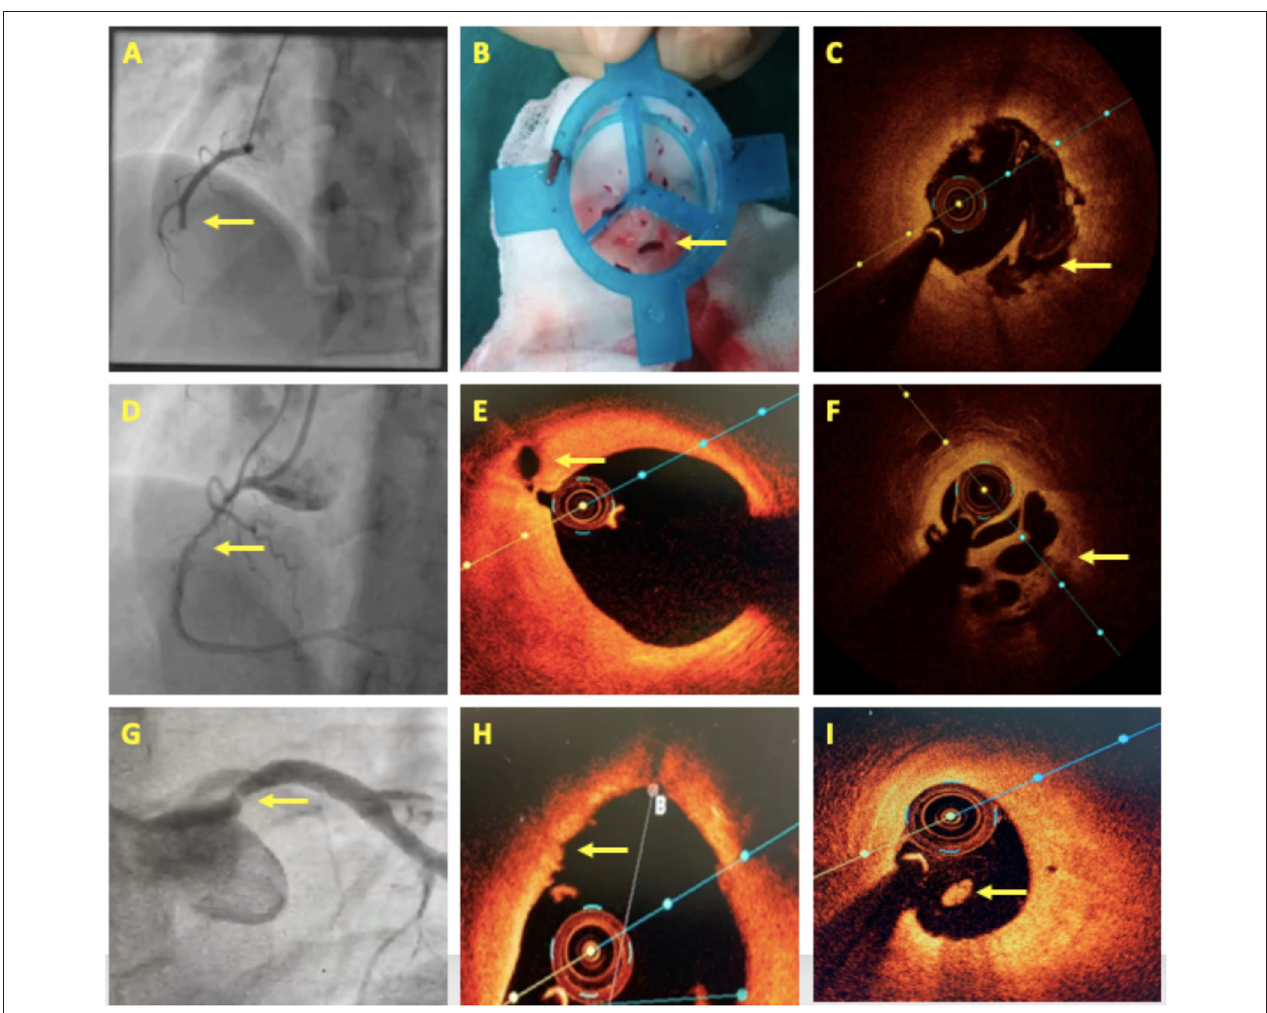
FIGURE 4 | OCT in acute coronary syndrome. (A–C) A case of acute inferior wall STEMI with mid dominant right coronary artery (RCA) thrombotic occlusion. Thrombus aspiration followed by OCT revealed plaque rupture. (D–F) A 4-day old case of inferior wall STEMI showing Mid-RCA haziness. OCT revealed proximal RCA plaque rupture and mid-RCA recanalized thrombus in a Swiss-cheese pattern. (G–I) A case of NSTEMI having a separate origin of LAD and LCx with a significant stenosis in the proximal LAD. OCT showed luminal irregularities, intact thick fibrous cap, and intraluminal white thrombus suggestive of plaque erosion. Areas of interest are highlighted with